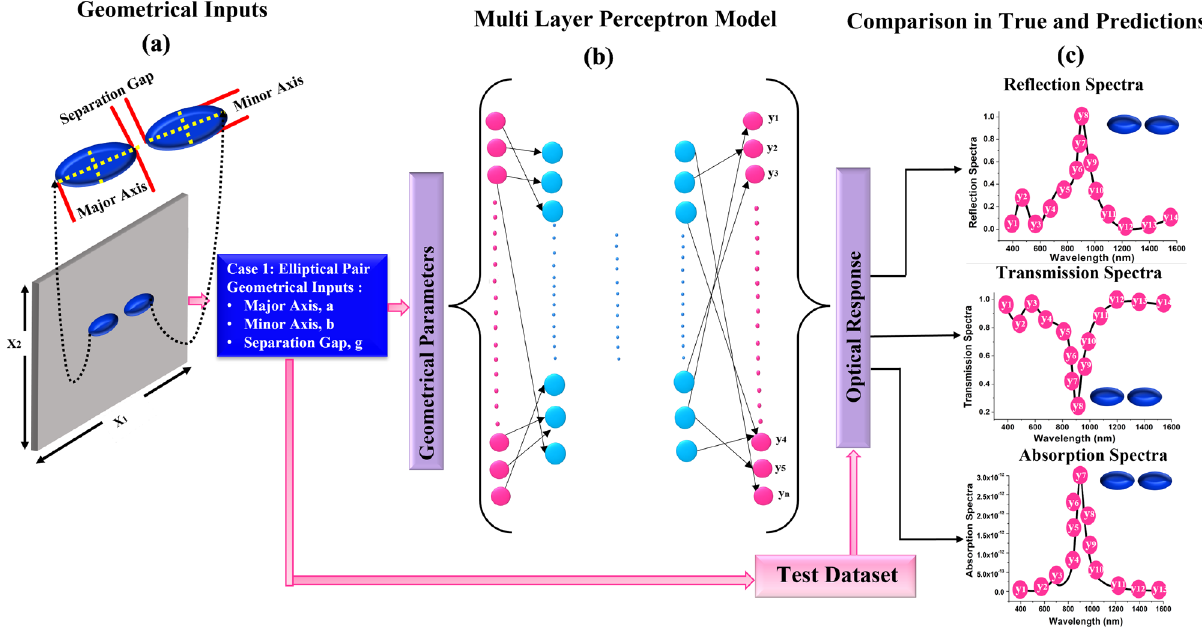
Figure 2. ( a ) Schematic of the structure of two elliptical nanostructures on SiO 2 substrate (The top and front views of a single unit cell with the geometrical parameters are represented in the insets). ( b ) A DNN model that predicts the optical response over a wavelength range for the given geometrical parameters and ( c ) Shows the predicted optical Reflection, Transmission and Absorption responses for a given geometrical